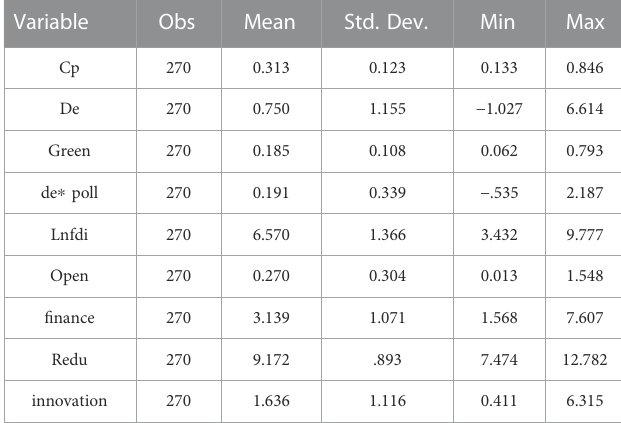
TABLE 4 Descriptive statistics of